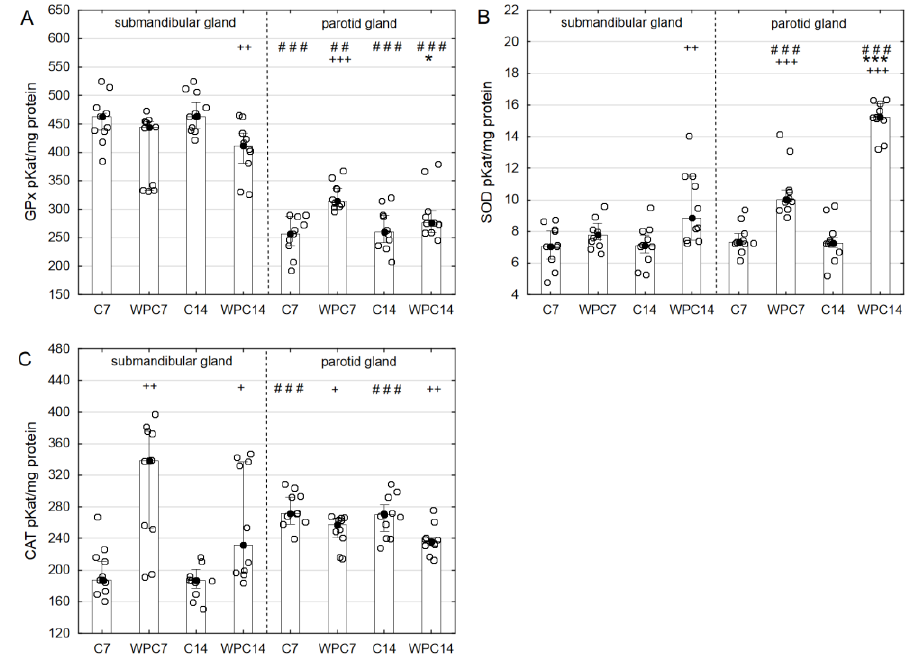
Figure 4. Glutathione peroxidase ( A ), superoxide dismutase ( B ) and catalase ( C ) activities in the salivary glands of rats from control and experimental groups. Abbreviations: C7, C14, control groups; WPC7, WPC14, experimental groups treated WPC-80; CAT, catalase; GPx, glutathione peroxidase; SOD, superoxide dismutase. Data are presented as a bar chart with the individual data points; + p < 0.05 of the C14 submandibular gland or of the C7 parotid gland, ++ p < 0.01 of the C14 submandibular gland, +++ p < 0.001 of the C7 parotid gland, * p < 0.05 of the WPC14 parotid gland, *** p < 0.001 of the WPC14 parotid gland, and ## p < 0.01 and ### p < 0.001 of the submandibular gland, respectively, for the same groups. Because the results were not normally distributed, the Mann– Whitney test was used to compare differences between the studied groups.